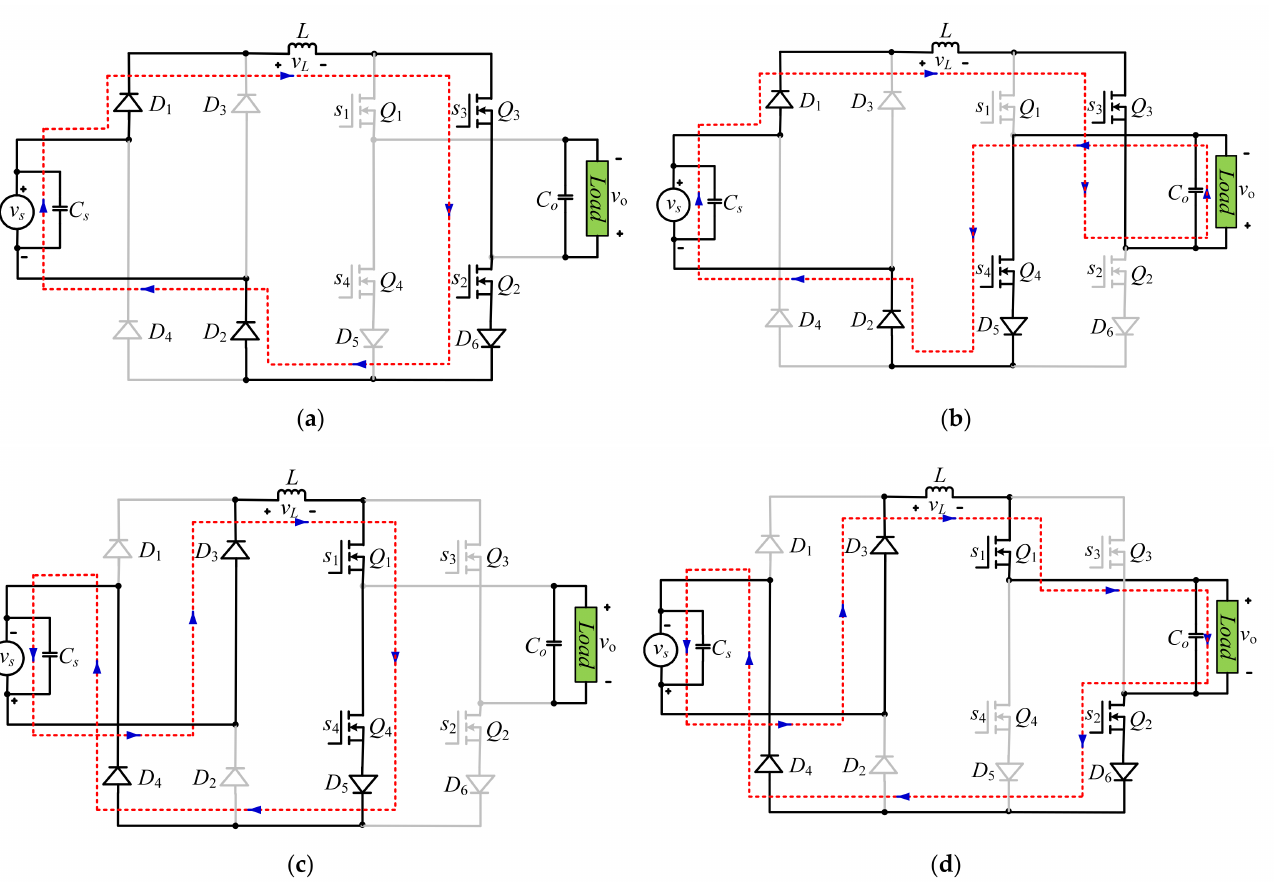
Figure 9. Out-phase voltage boost operation during ( a , c ) shoot-through interval of positive and negative input voltage, respectively; ( b , d ) energy transfer interval of positive and negative input voltage,